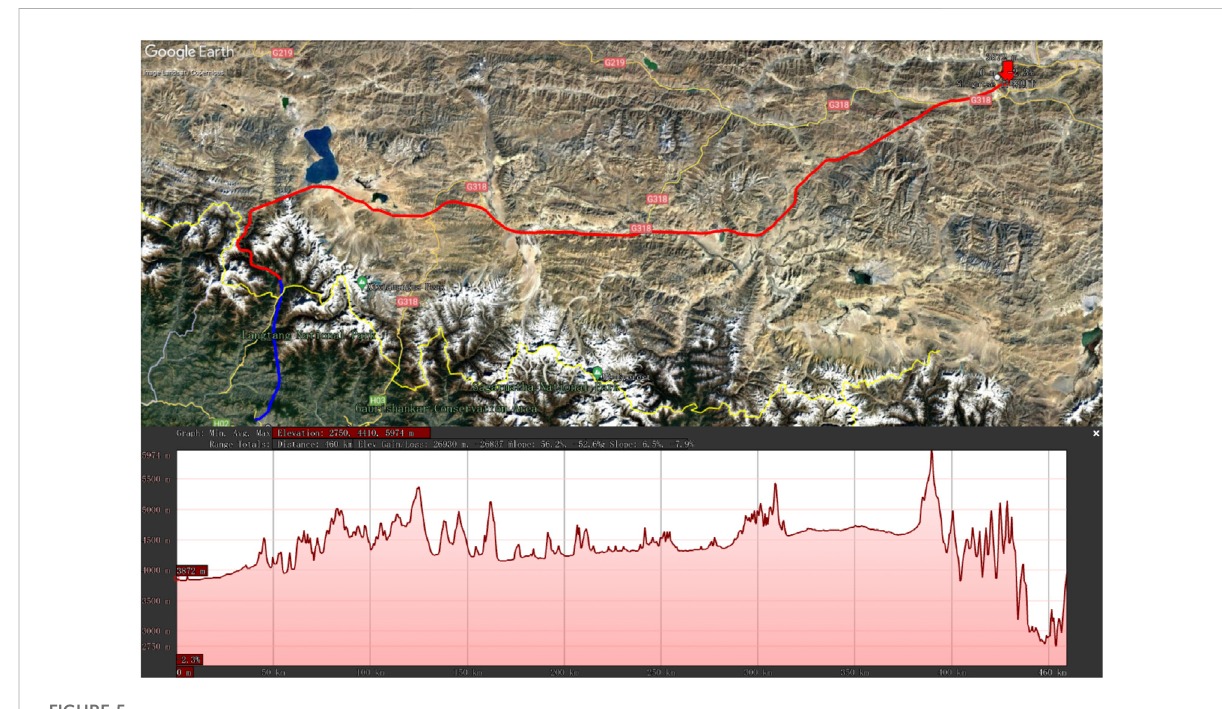
FIGURE 5 Elevation change along China – Nepal